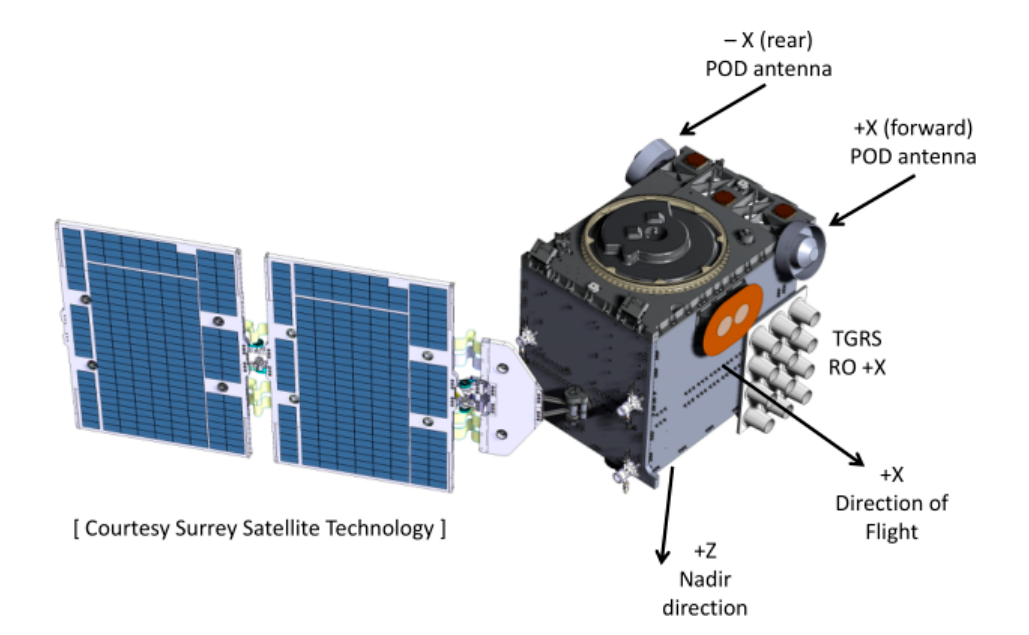
Figure 1. Satellite Structure of COSMIC-2.